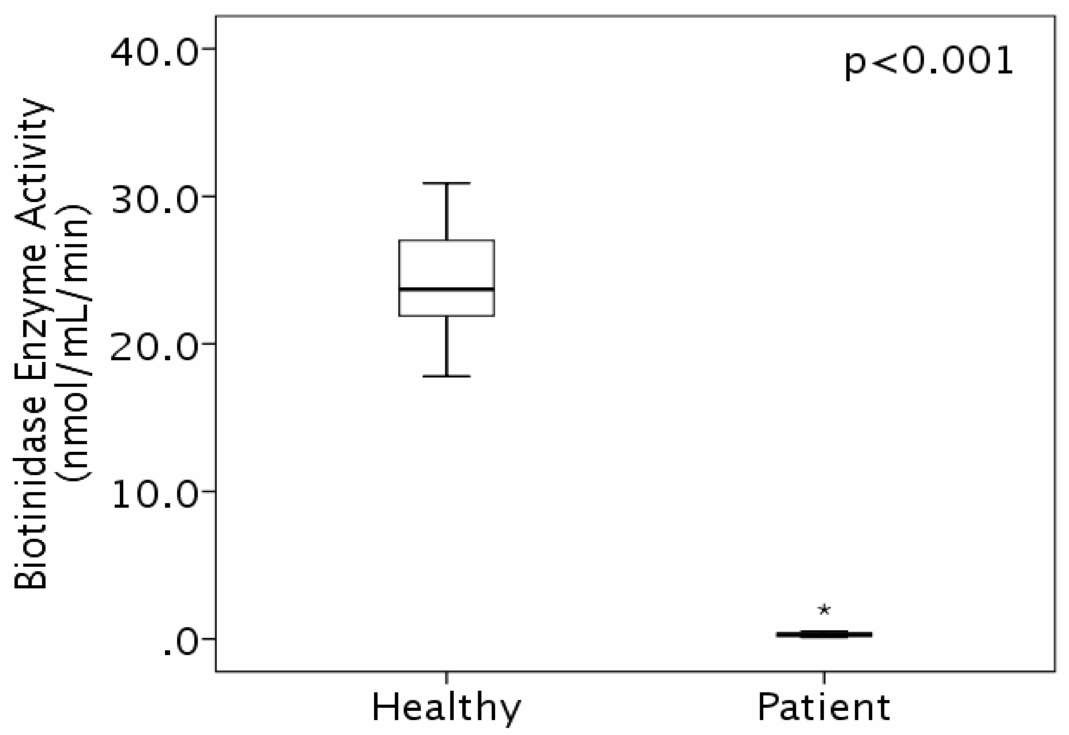
Figure 2. Biotinidase enzyme level in biotinidase gene ( BTD )-deficient patients ( n = 10) compared to their healthy family members ( n = 17) measured as nmol · mL − 1 · min − 1 . *: Outlier